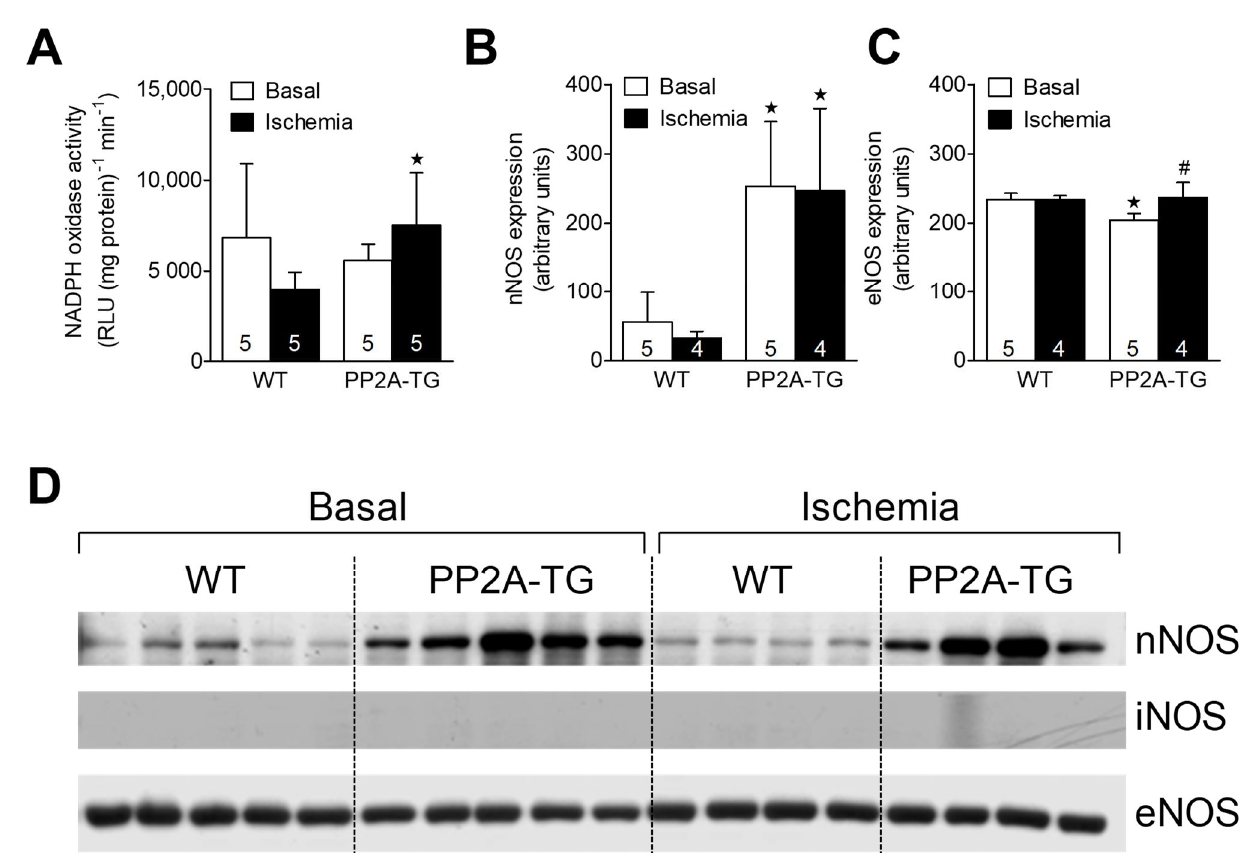
Figure 7. The cardiac activity of NADPH oxidase is plotted in ( A ). Western blot data for the expression of neuronal ( B ) and endothelial ( C ) nitric oxidase synthase (nNOS and eNOS) in the hearts from WT and PP2A-TG are plotted. The open bars indicate basal perfusion conditions and filled bars indicate values at the end of the ischemia. Original nitrocellulose membranes are shown in ( D ) for expression of nNOS (upper tracing) or eNOS (lower tracing), before ischemia (basal, left-hand side) and after 120 min of ischemia (right-hand side). The inducible NOS (iNOS) was not detectable by Western blotting (middle tracing). In the supplementary Figure S7, the corresponding fast green stained membranes are shown to demonstrate equal protein loading. The data for nNOS and eNOS are summarized as means and SD for 4–5 hearts and are presented in bar diagrams in ( B and C ). ★ p < 0.05 vs. WT, # p < 0.05 vs. basal conditions.